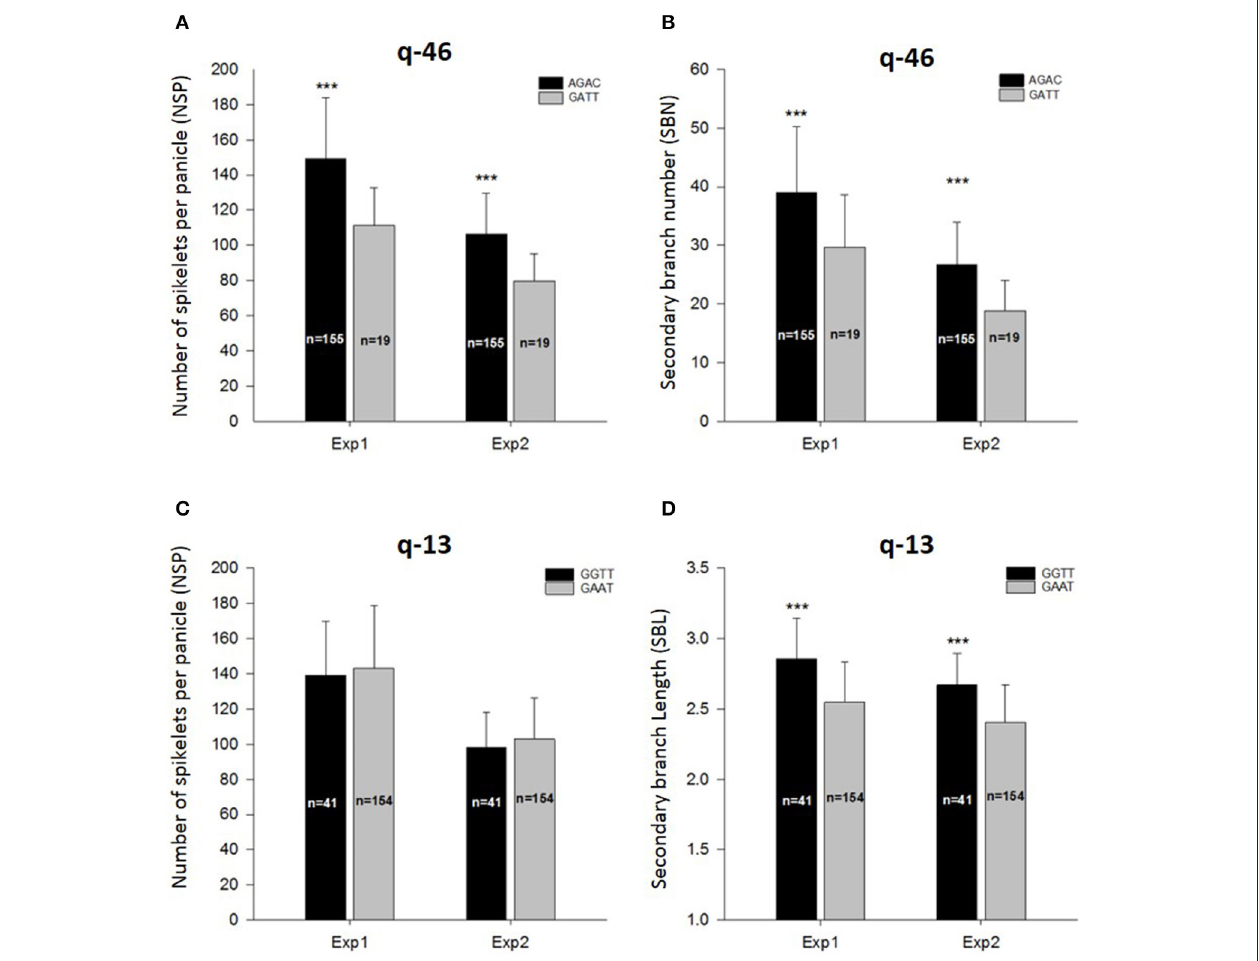
FIGURE 4 | Allelic combination for q-46 (A,B) and q-13 (C,D), and their effect on the number of spikelets per panicle, secondary branch number and secondary branch length. ***Indicate significant differences at p < 0.001 between allelic combination for each